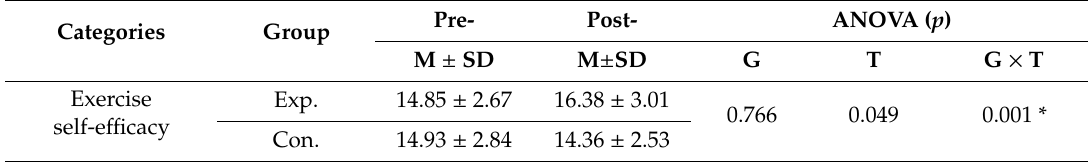
Table 5. E ff ects of augmented-reality-based exercise on exercise self-e ffi cacy for older